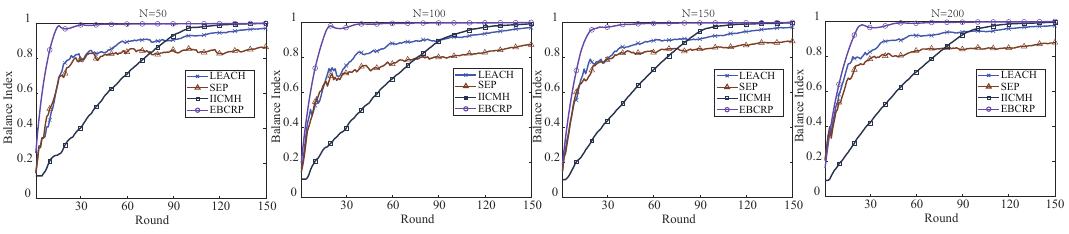
Figure 9. The curve of energy consumption balance index of different methods.